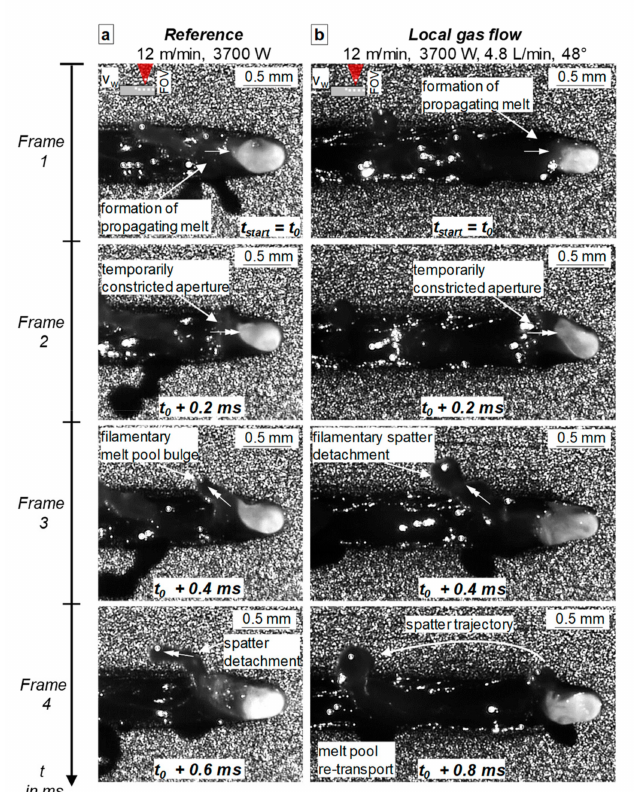
Figure 5. Spatter formation mechanism representing in time of: ( a ) Reference process; ( b ) Gas-assisted